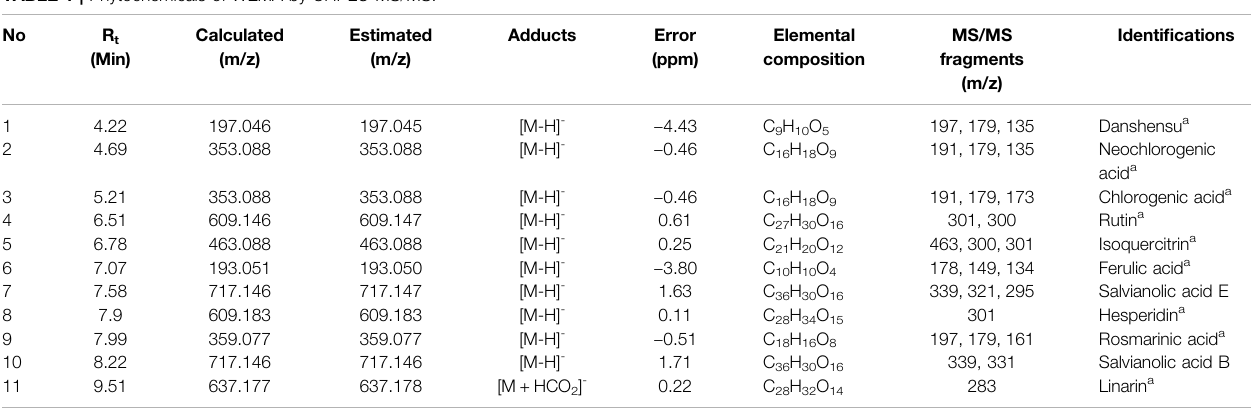
TABLE 1 | Phytochemicals of WEMA by